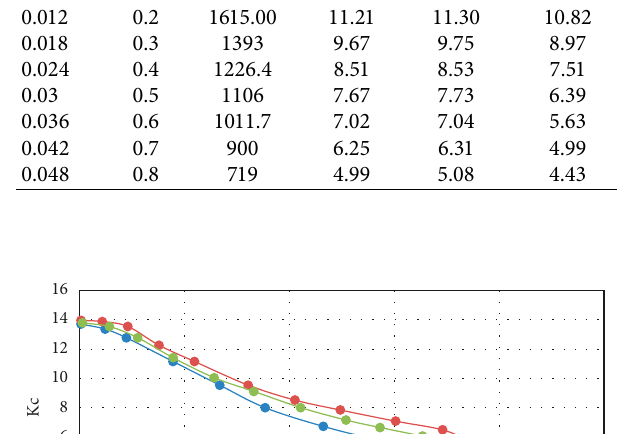
Figure 9: Plate with central crack under uniform tension